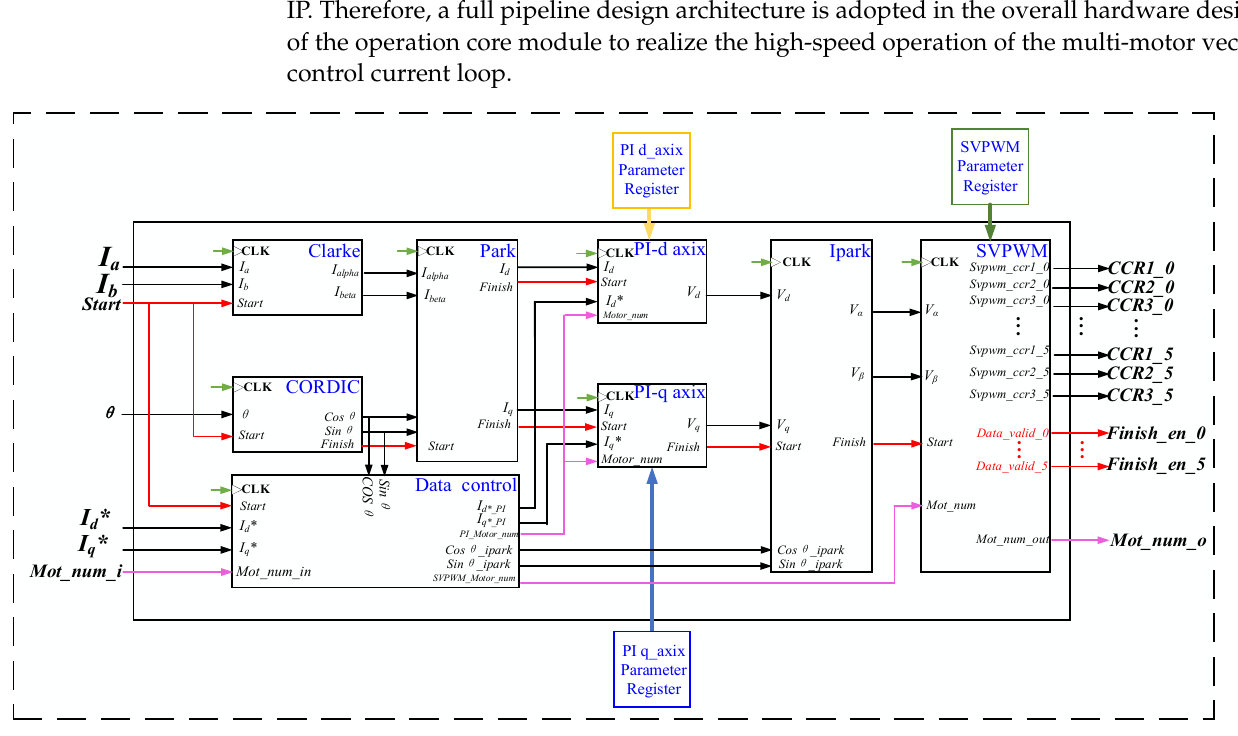
Figure 6. Overall diagram of operation core